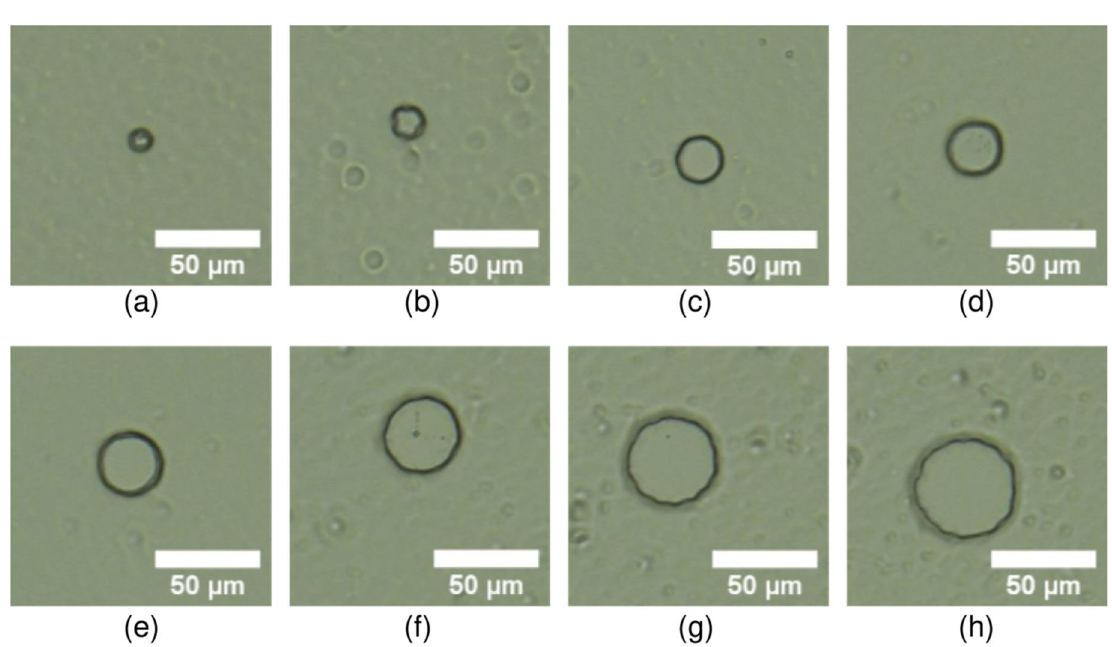
Figure 4. The concave structures of the bioresist patterns with different diameters. Pattern diameter ( a ) 10 µm, 15 µm, ( c ) 20 µm, ( d ) 25 µm, ( e ) 30 µm, ( f ) 35 µm, ( g ) 40 µm, and ( h ) 45 µm. The outside of the circles is coated with a